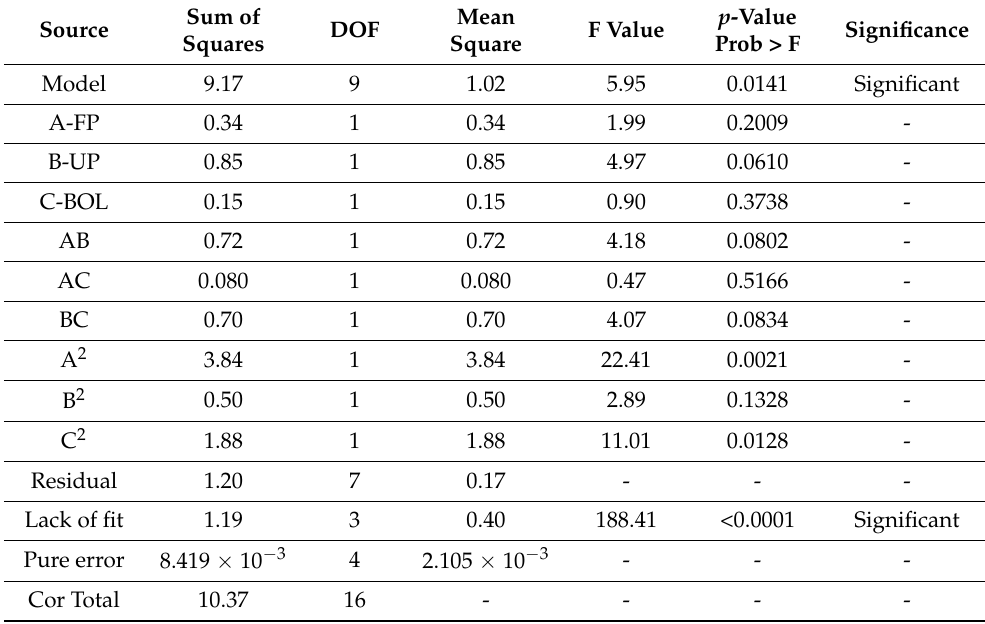
Table 6. Analysis of variance (ANOVA) table for optimization of the models. Source